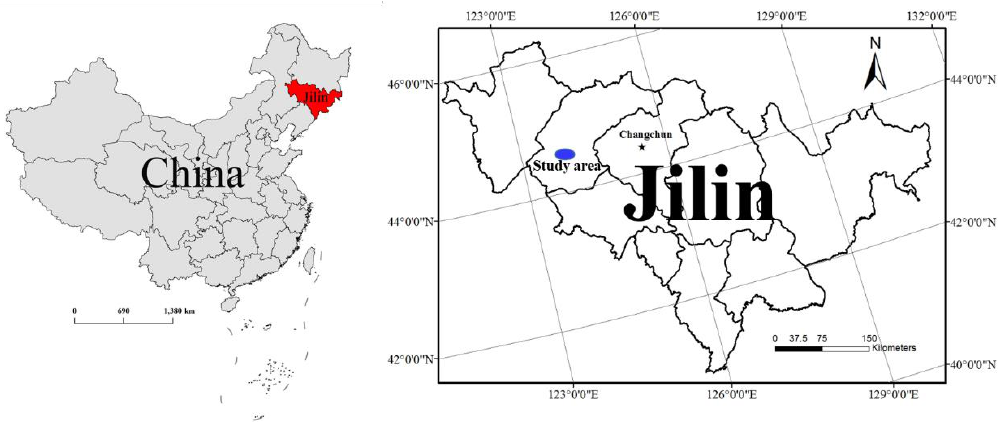
Figure 1. The location map of the study area.